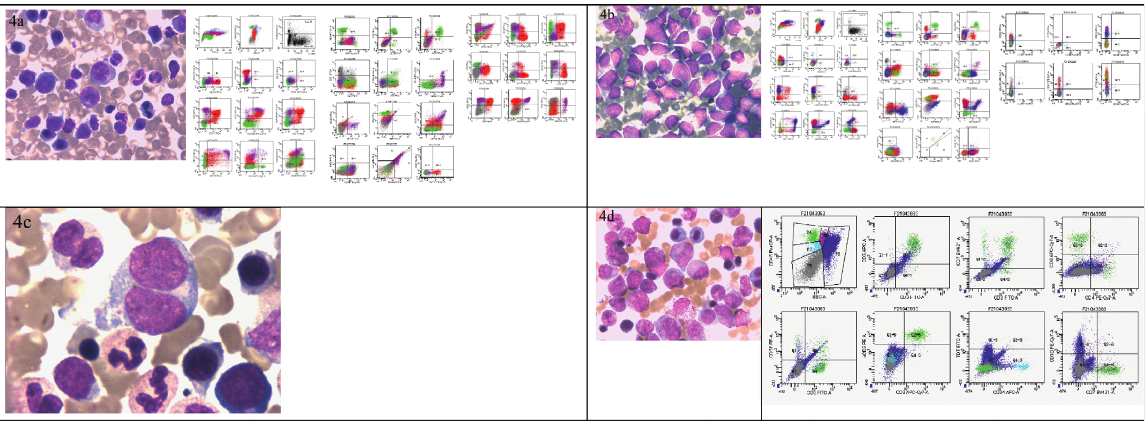
Figure 4: Results of bone marrow